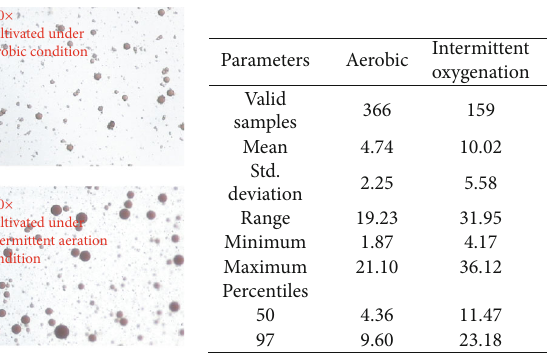
Figure 3: Morphology of emulsi fi ed oil droplets in cultures.